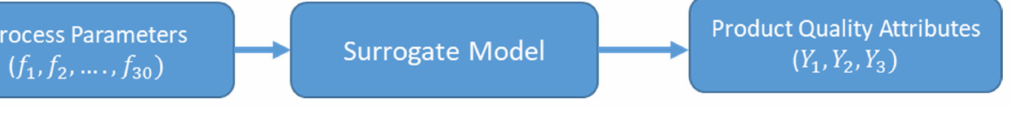
Figure 1. Surrogate